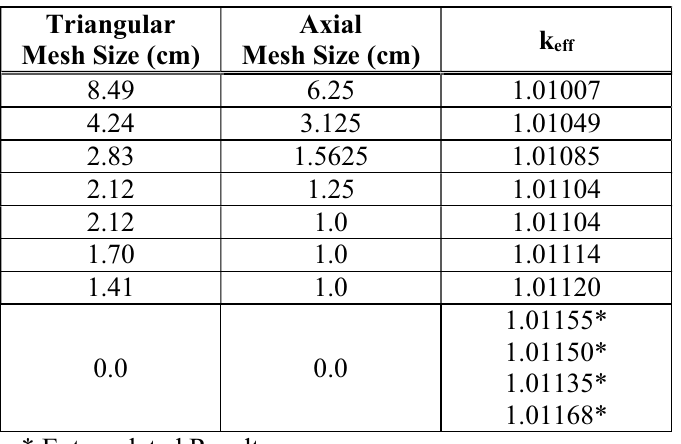
Table II. DIF3D-FD VVER-440 Eigenvalue Results